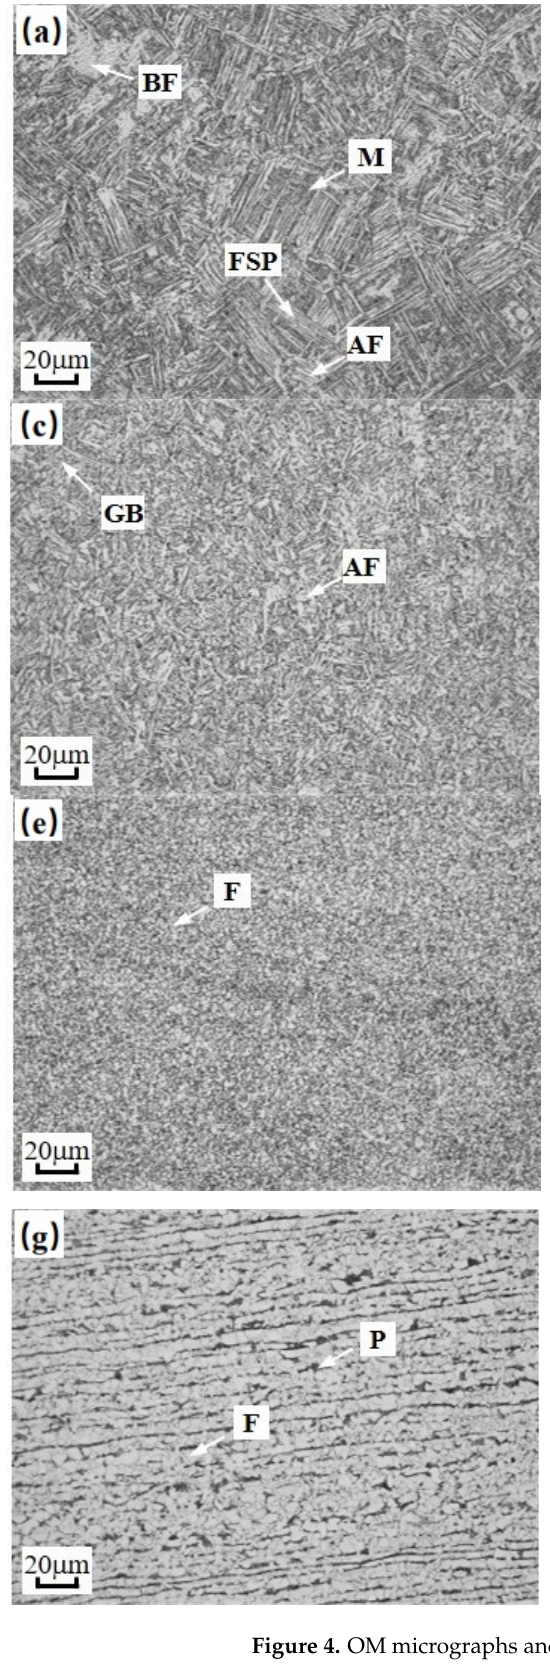
Table 3. Results of tensile test for flash-welded joint. Number